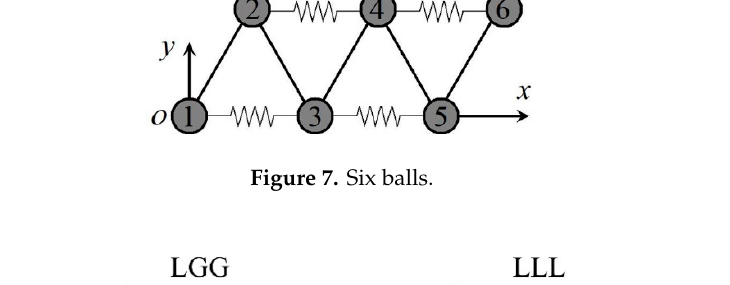
Figure6. Triplependulum: GlobalerrorofHamiltonianofLLL,LGL,LLGandLGGwith m = 2, 3, ··· , 6 Figure 6. Triple pendulum: Global error of Hamiltonian of LLL, LGL, LLG and LGG with and time step η = 0.1.